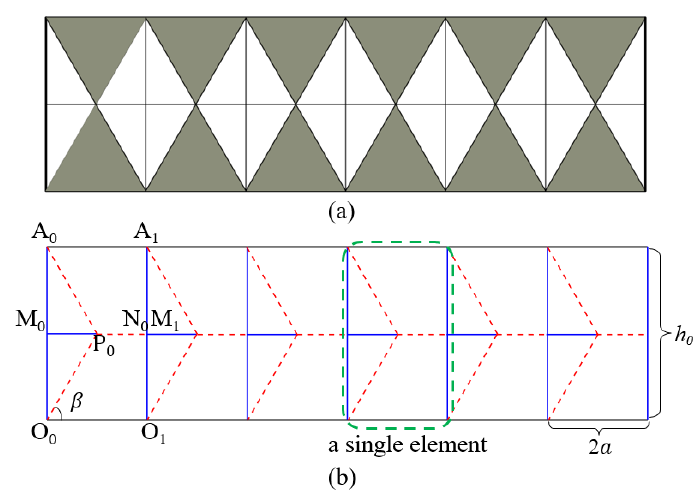
Figure 8. ( a ) Preliminary new crease pattern in a planar form. ( b ) Optimized new crease pattern, RC-ori. Red dashed lines are valley-foldlines, and blue lines are mountain-foldlines. ( n =